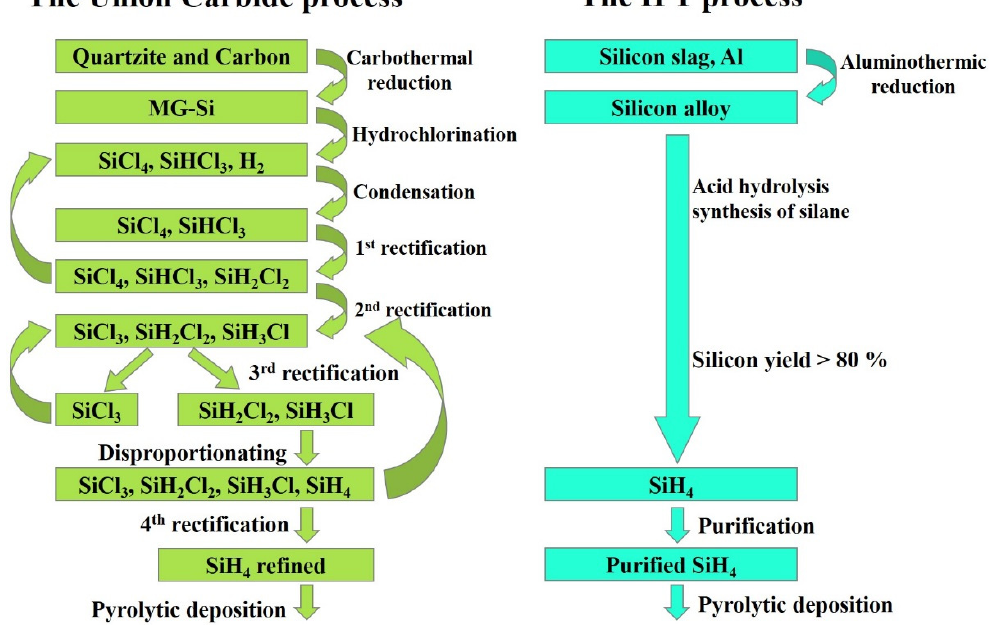
Figure 2. Process comparison: Union Carbide corporation vs Institute of Physics and Technology (IPT).